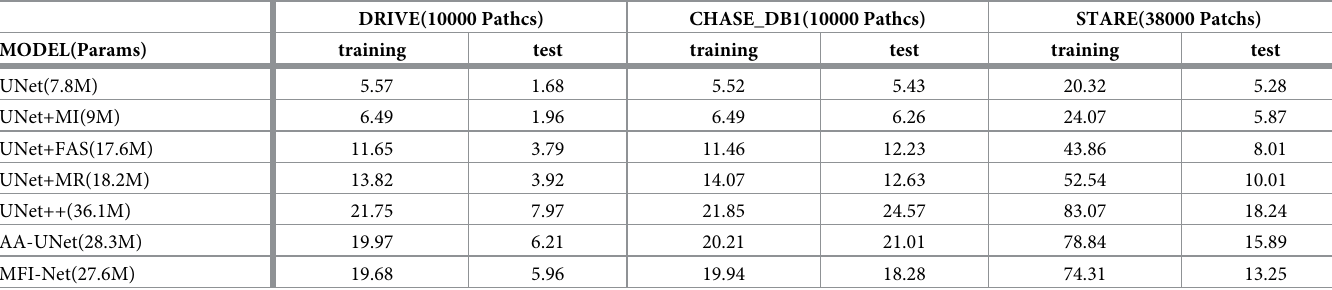
Table 6. Details of the parameter amount and time cost of different